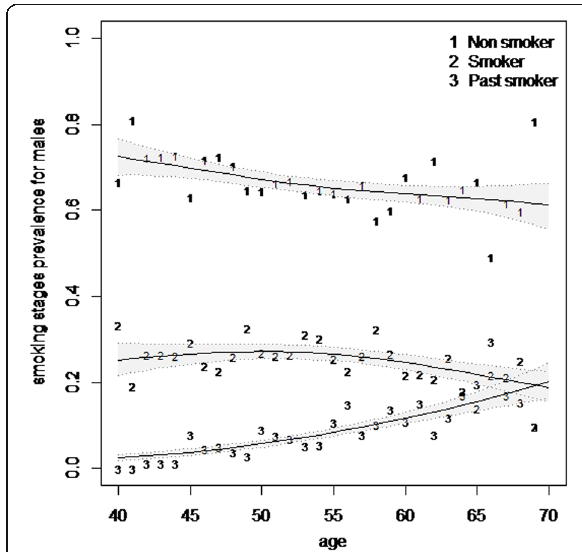
Fig. 2 Smoothed prevalence of tobacco smoking stages in Shahroud male population (40 – 69 years) using a multinomial P-spline. The shaded areas represent 95% confidence